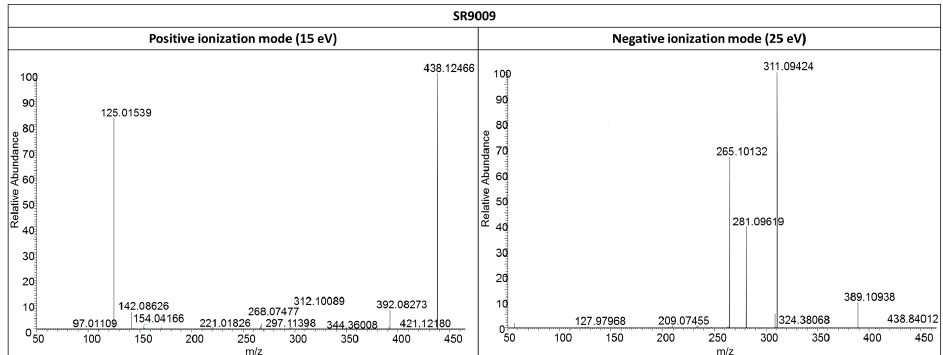
Figure 4. LC–HRMS/MS product ion scan mass spectra of SR9009 in both positive ( left column ) and negative ( right column ) ionization mode at a collision energy (CE) of 15 and 25 eV, respectively.